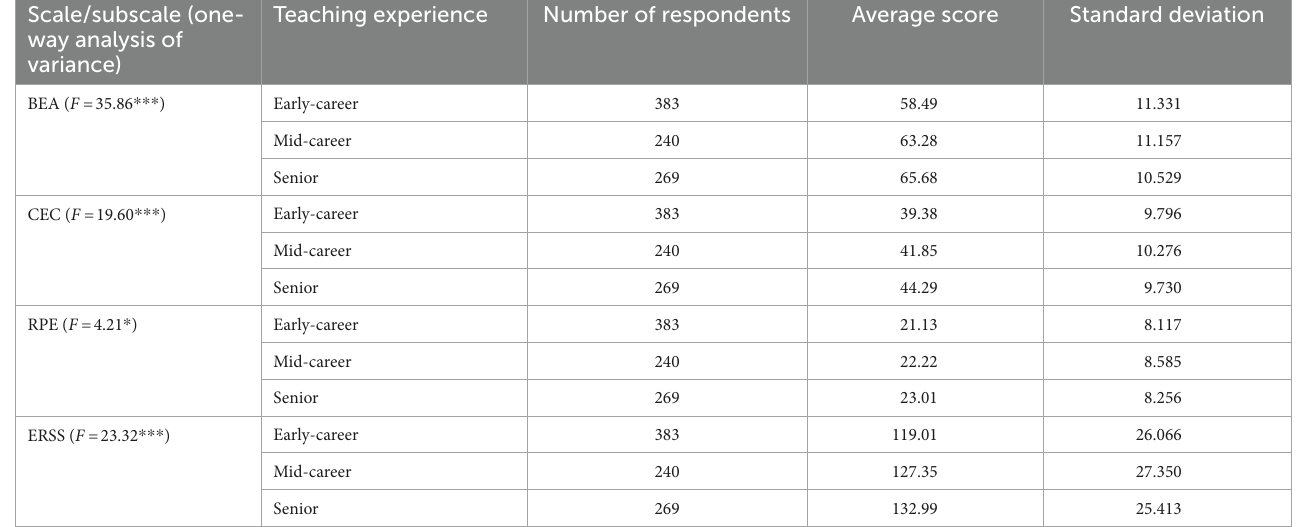
TABLE 4 Regional norms for educational research skills and accomplishments among rural teachers in Hunan Province. Scale/subscale (one- way analysis of